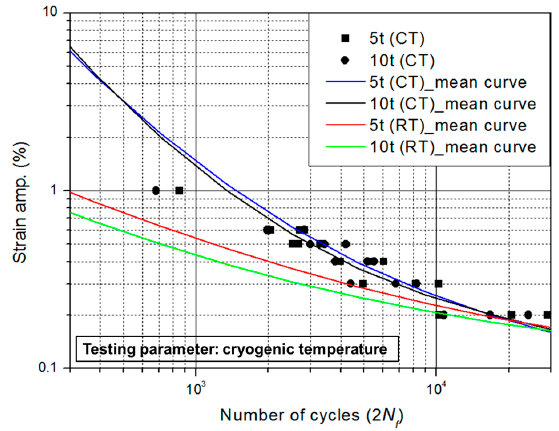
Figure 11. Strain–life curve at cryogenic temperature.